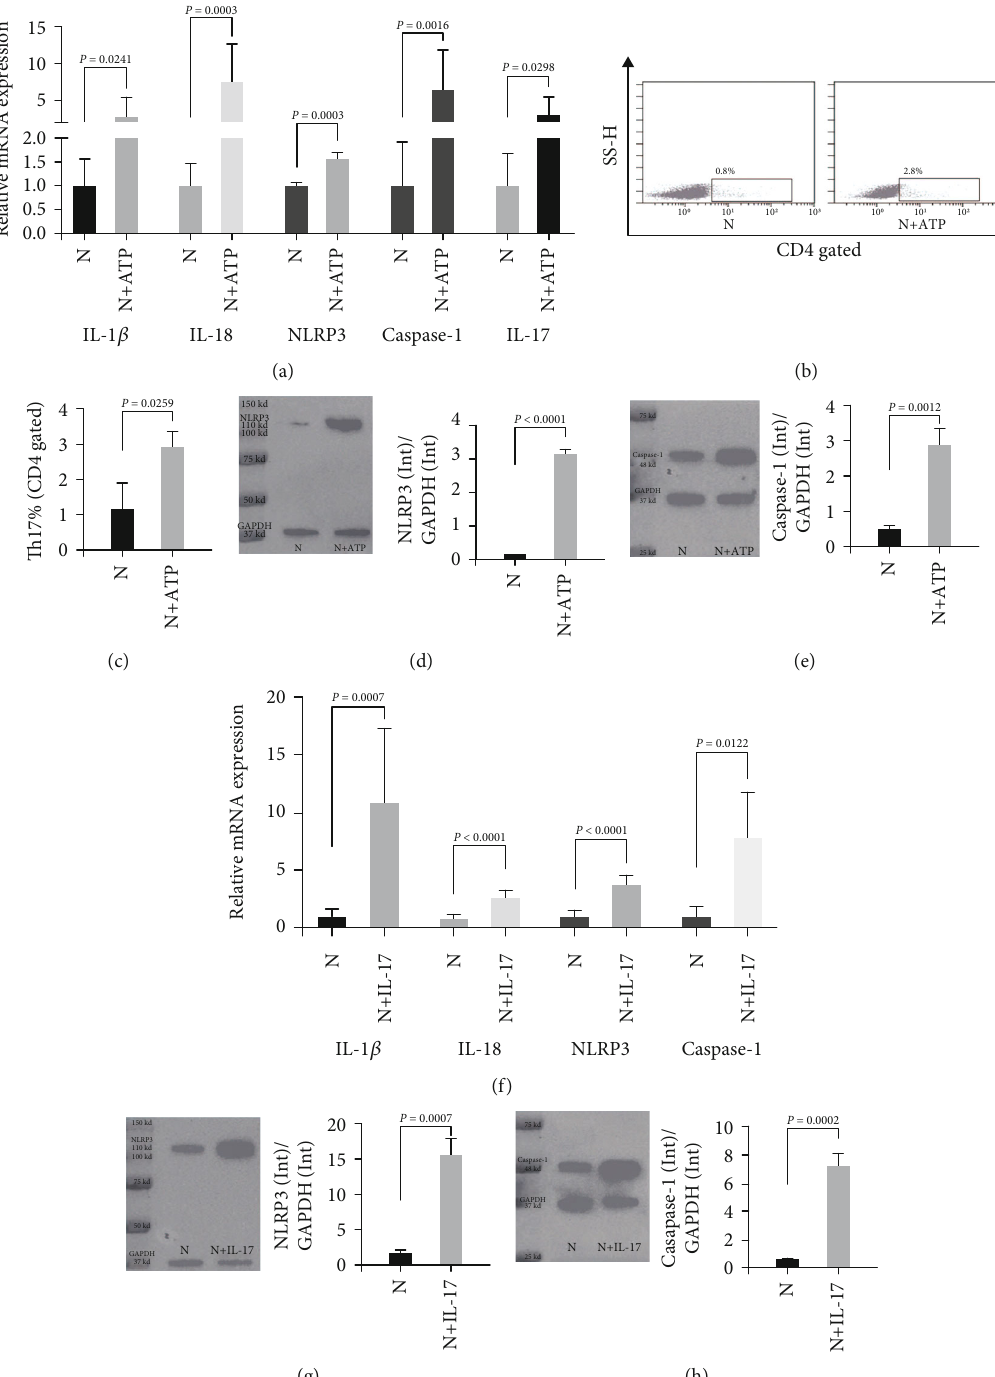
Figure 5: Orchestration of NLRP3 in fl ammasome and Th17 cells in CVB3-induced myocarditis. (a) The relative mRNA expression of IL-1 β , IL-18, NLRP3, Caspase-1, and IL-17 in N and N+ATP groups in the coculture system. (b) The proportion of Th17 cells in N and N+ATP groups in the coculture system. (c) Statistic calculation column of Th17 proportion in N and N+ATP groups in the coculture system. (d) The protein level of NLRP3 in N and N+ATP groups in the coculture system. (e) The protein level of Caspase-1 in N and N+ATP groups in the coculture system. (f) The relative mRNA levels of IL-1 β , IL-18, NLRP3, and Caspase-1 in the CD11c + DC cells stimulated with or without IL-17. (g) The protein level of NLRP3 in CD11c + DC cells stimulated with or without IL-17. (h) The protein level of Caspase-1 in CD11c + DC cells stimulated with or without IL-17. (a – e) were acquired from the CD11c + DC and CD4 + T cell coculture system stimulated by LPS with (N+ATP) or without ATP (N). (f – h) were acquired from CD11c + DC cells stimulated with IL-17 (N+IL-17) or without IL-17 (N). Statistical description: the P value in the fi gure has been marked between the corresponding